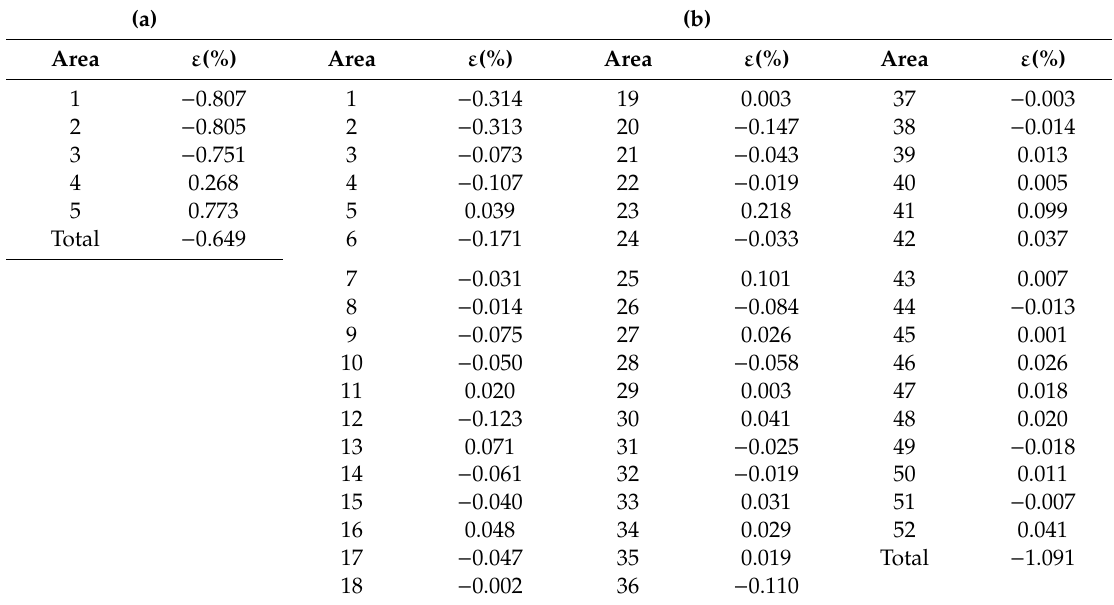
Table 1. Transformation strain calculated by the electron backscatter di ff raction (EBSD) results of the equiatomic TiPd alloy. ( a ) 90 and ( b ) 0-degree